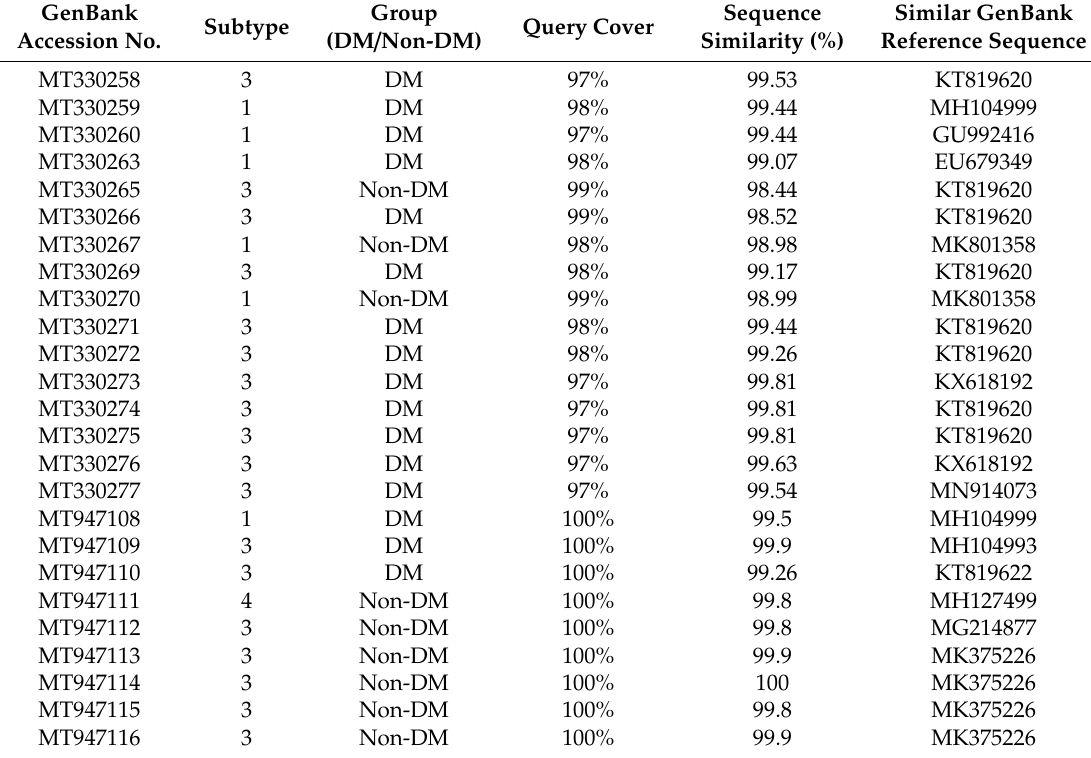
Table 4. Accession numbers of positive samples used in the phylogenetic reconstruction in this study.